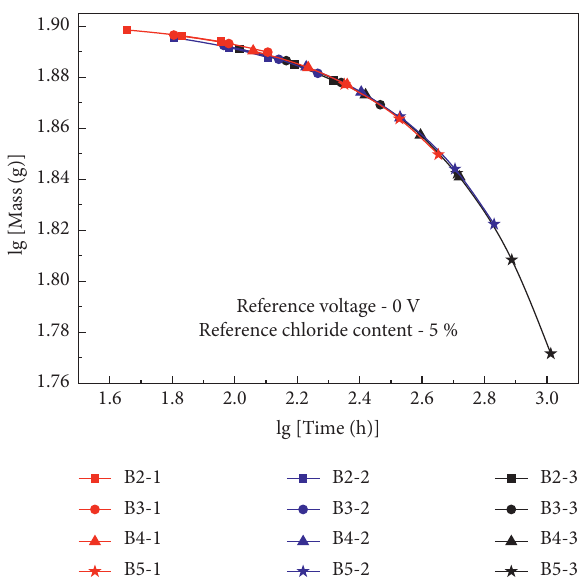
Figure 10: Master curve with 5% chloride content and